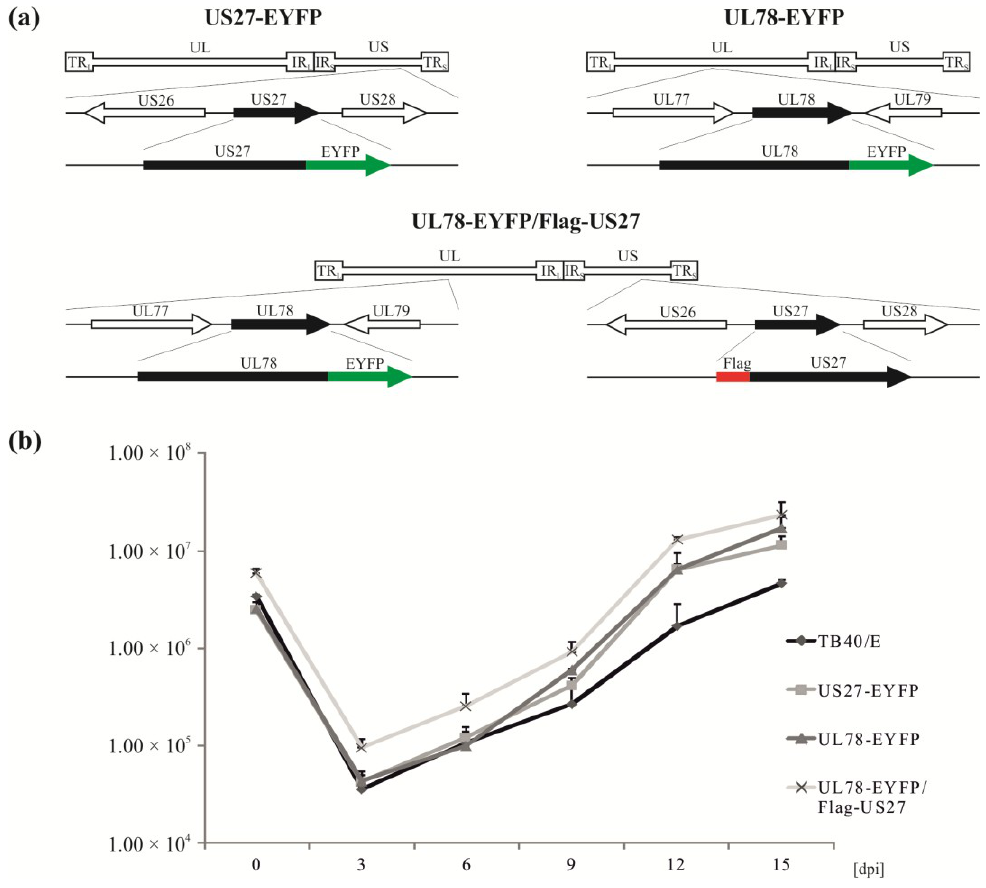
Figure 2. Construction and characterization of recombinant HCMVs expressing tagged US27 and/or UL78. ( a ) Schematic illustration of the US27 and UL78 genomic loci of HCMV strain TB40/E. Recombinant viruses were generated with C -terminal EYFP (US27 or UL78, upper panel) or N -terminal FLAG-tag (US27, lower panel); ( b ) Growth kinetics of recombinant TB40/E-derived viruses. HFF cells were seeded and infected three days later with wild-type and recombinant viruses at an MOI of 0.1. Virus supernatant samples were harvested at indicated times (dpi, days post infection) and digested with proteinase K. Viral DNA was quantitated via Taqman PCR to determine the release of viral particles from infected cells. Each infection was performed in triplicate, and the standard deviations are